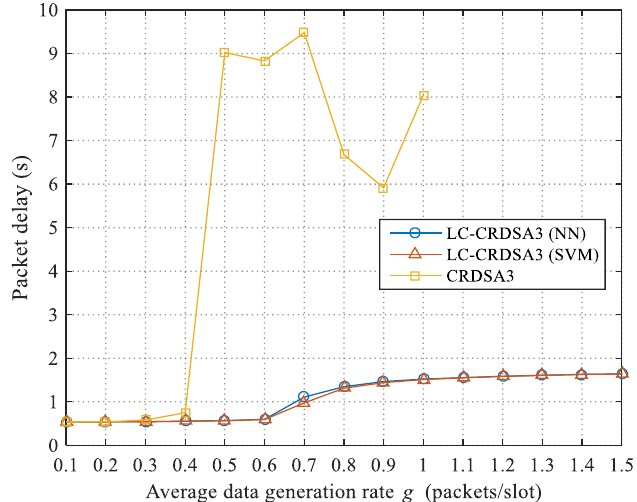
Figure 9. Comparison of packet delay between LC-CRDSA3 and CRDSA3.